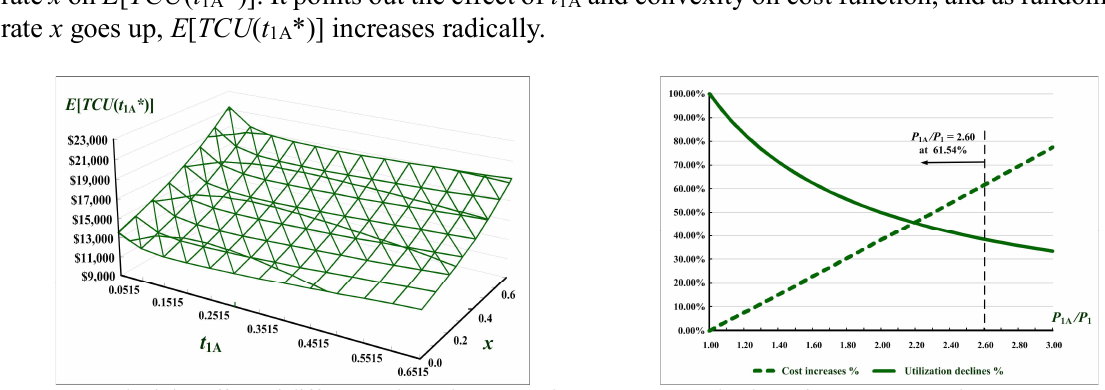
Fig. 17. Behavior of “system cost increase percentage” versus “machine utilization decline